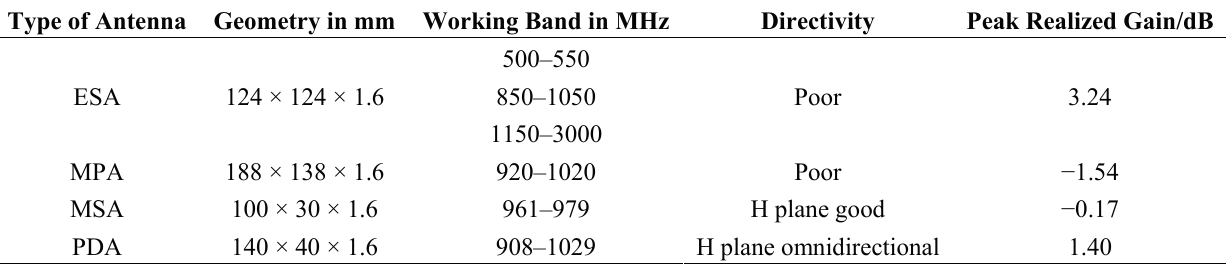
Table 2. Parameters of four types of UHF